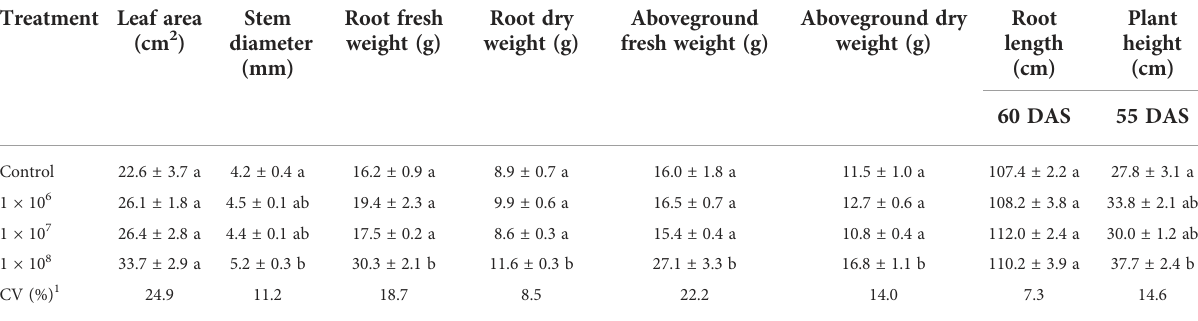
TABLE 5 Leaf area, stem diameter, root length, height and fresh and dry weight of the root and aboveground of cotton plants treated with different concentrations of Trichoderma lentiforme CMAA 1585. Treatment Leaf